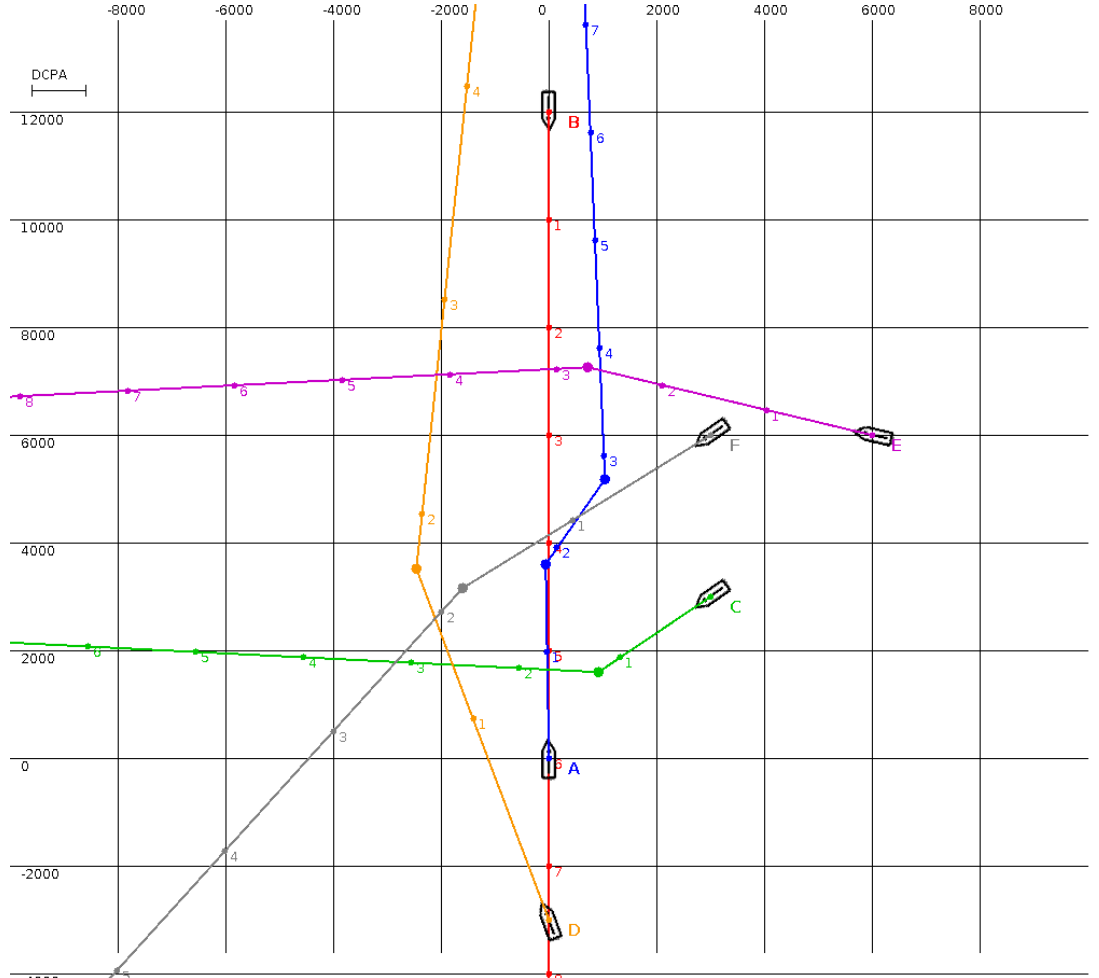
Figure 3. A multi-surface vehicle encounter involving 6 vehicles. The initial positions are marked by surface vehicle contours. The initial course for vehicles A and D is 000, for vehicle B is 180, for vehicles C and E is 270, and for vehicle F is 225. The anti-collision trajectories for each surface vehicle generated by the MBSA are presented in different colors.